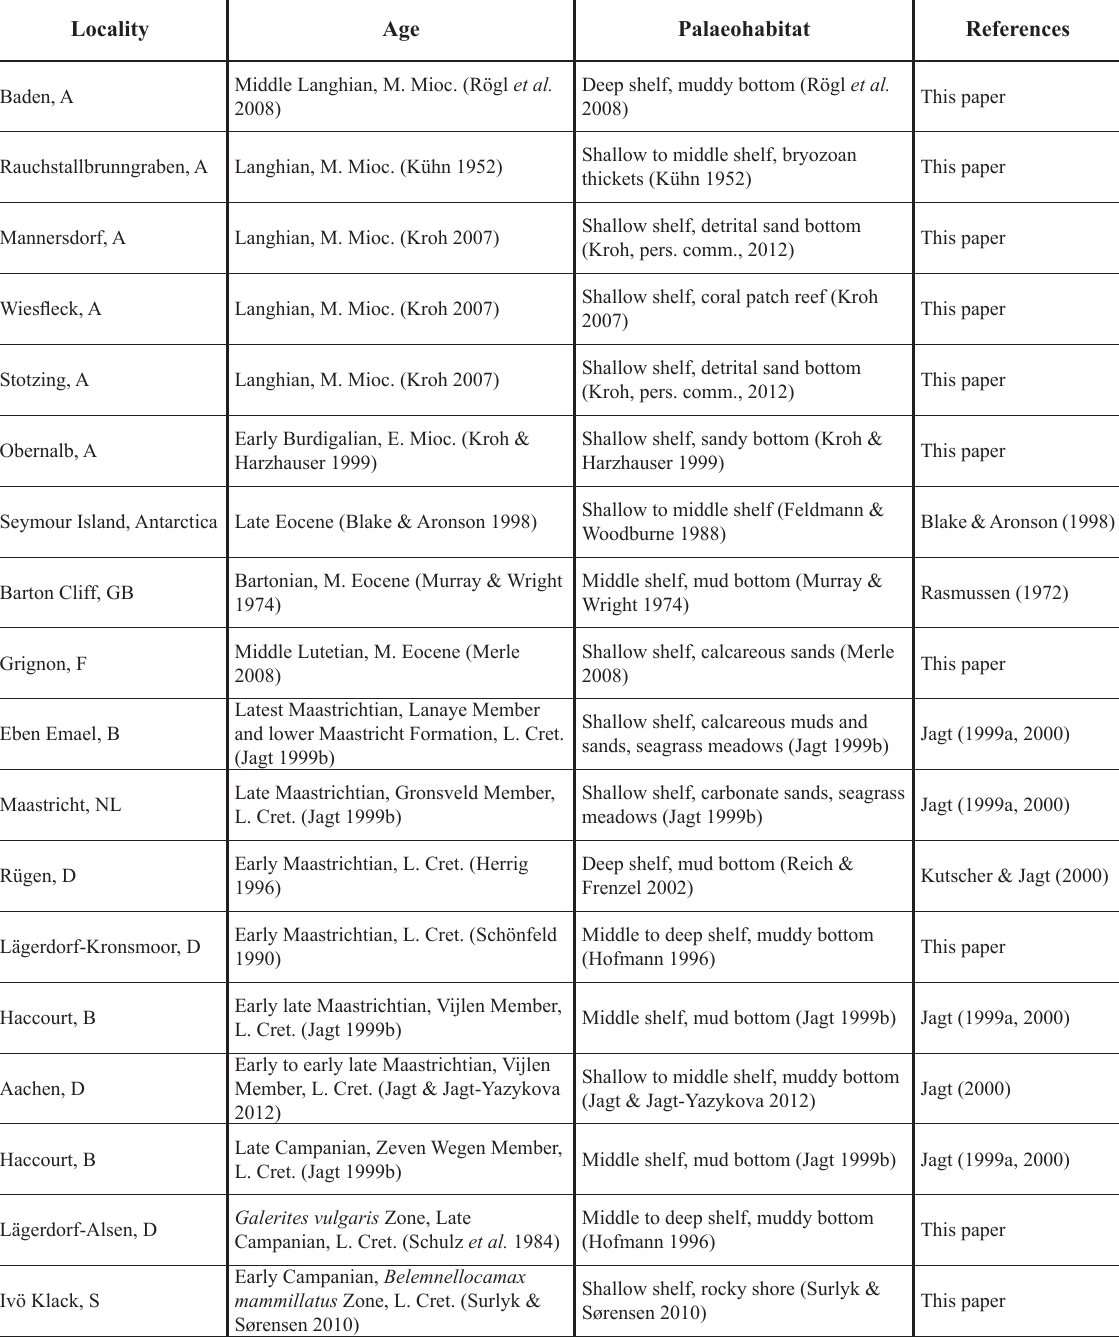
Table 1. Locality details of previously published and new shallow-water ophiuroid assemblages (as studied herein), including reference-supported details on the age and, whenever available, the stratigraphic unit, as well as palaeodepth classification (see section Material and methods) and substrate interpretation. References for previously published ophiuroid assemblages are given. Country and state acronyms: A = Austria; B = Belgium; CH = Switzerland; CN = China; CZ = Czech Republic; D = Germany; E = Spain; F = France; GB = Great Britain; H = Hungary; I = Italy; IND = India; JP = Japan; MO = Morocco; NL = Netherlands; P = Portugal; PL = Poland; S = Sweden; TX = Texas. Age acronyms: E = early; L = late; M = middle; Cret. = Cretaceous; Jur. = Jurassic; Mioc. = Miocene; Tr. =